Question: Describe this figure in one sentence.
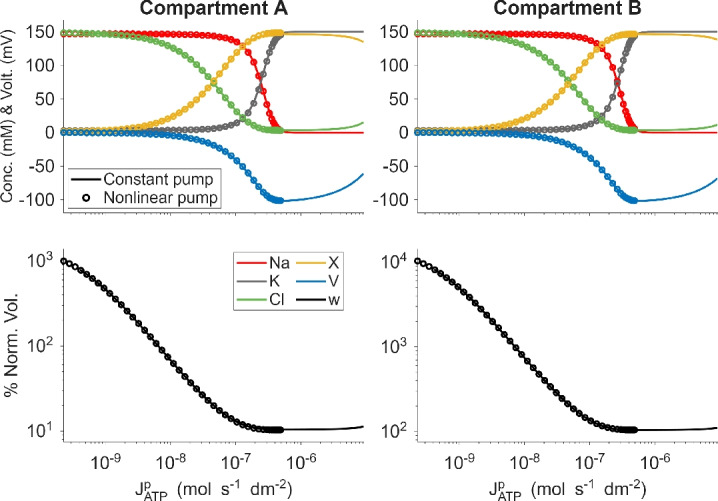
Answer: Steady-state values of the ABp system are plotted against ATP consumption rate for the constant NKA (solid curve) and the nonlinear NKA ( 22 ) (circles) (color figure online)